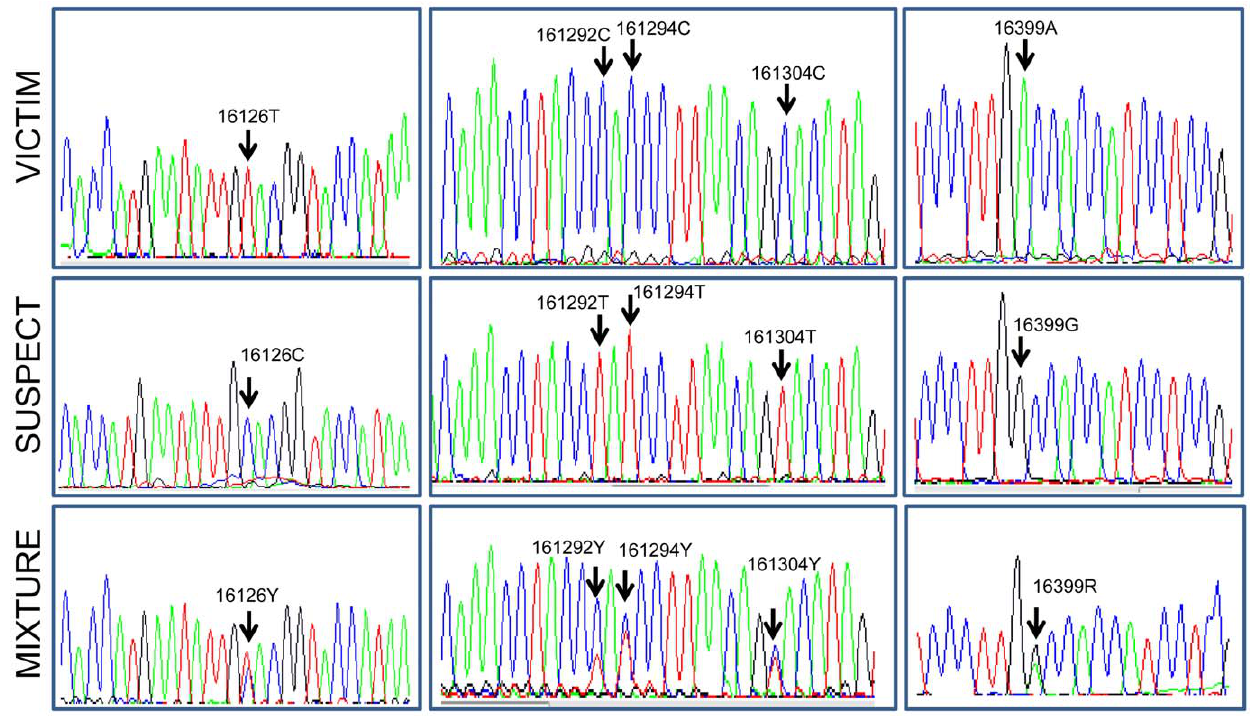
Figure 4. Sequencing electropherograms of the profiles discussed in example 3.